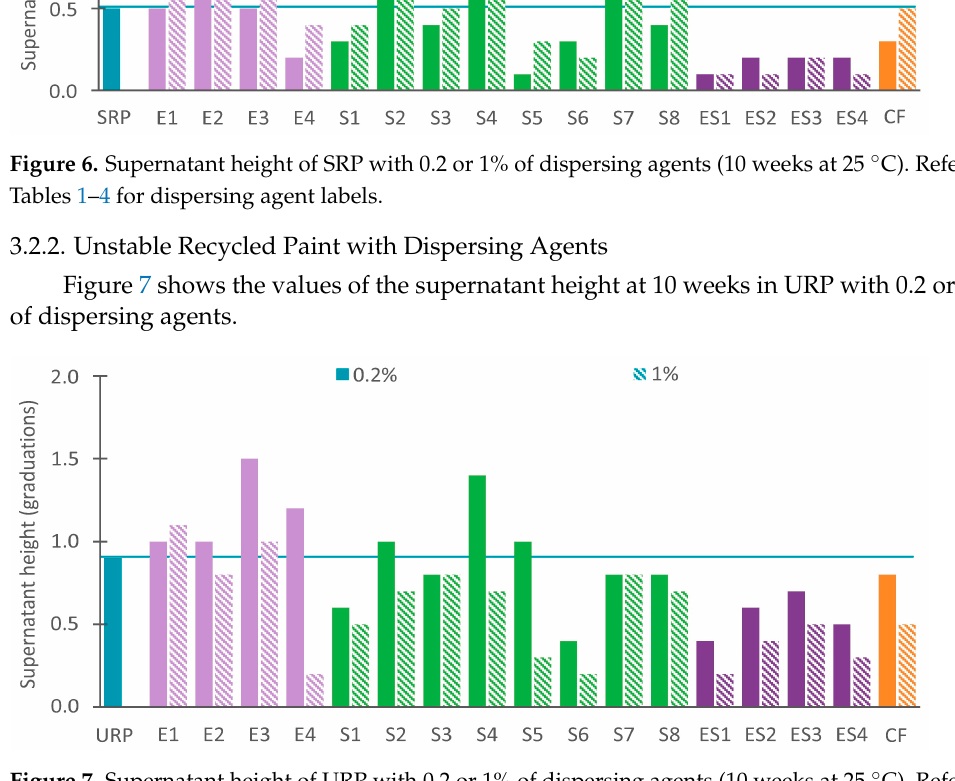
Figure 7. Supernatant height of URP with 0.2 or 1% of dispersing agents (10 weeks at 25 ◦ C). Refer to Tables 1–4 for dispersing agent